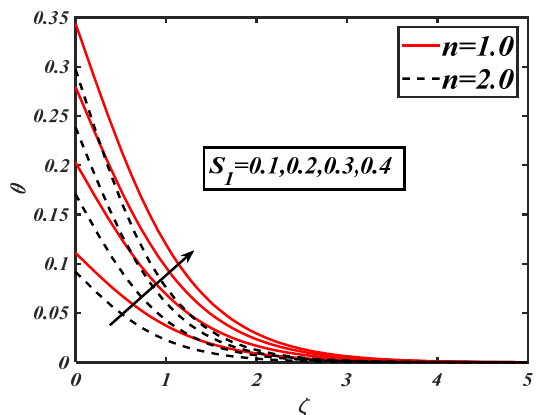
θ . Figure 12. S 1 illustration against θ . θ .